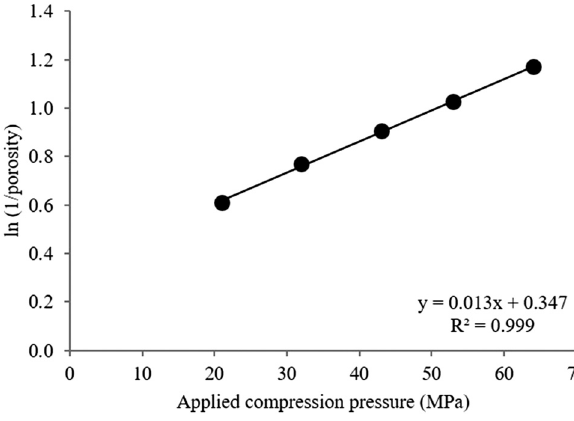
Figure 3: Out - of - die Heckel plot of MCC